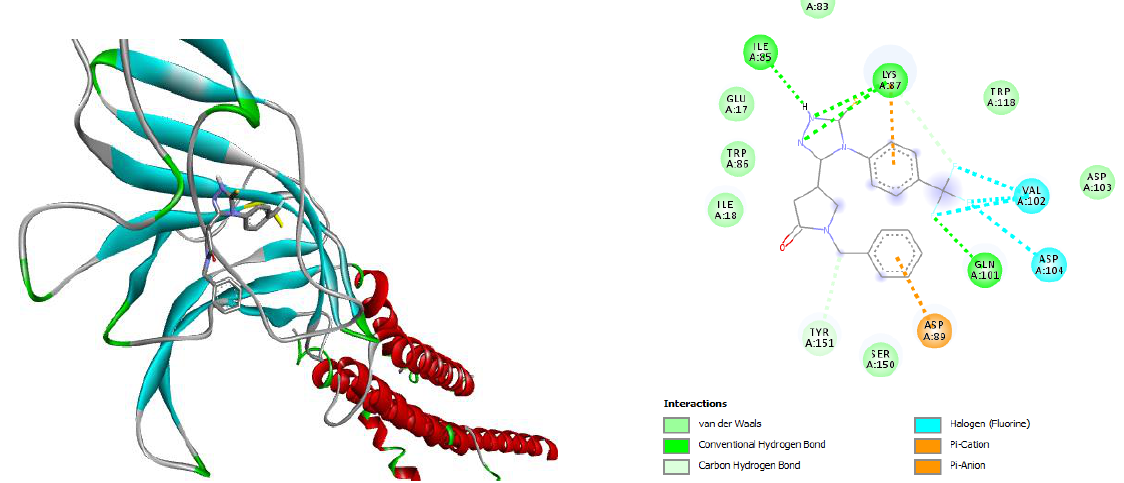
Fig 6. Superposition of molecule 2 and diagram of intermolecular interactions in complex with nicotinic